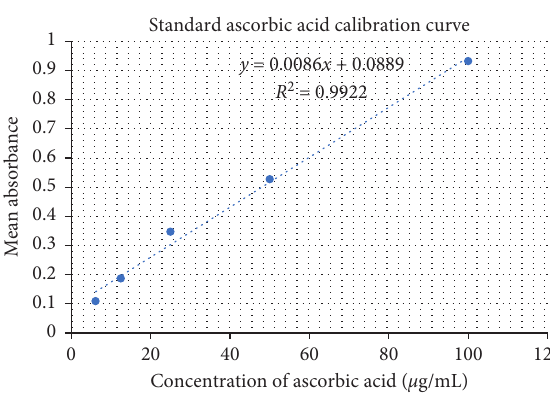
Mo VI O 7 − (formed in ascorbic 40 4 8